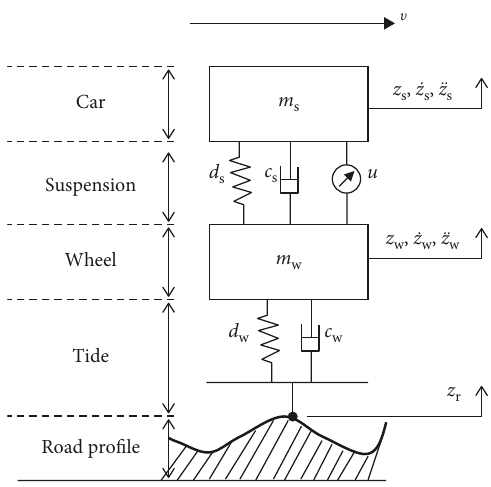
Figure 1: Physical model of a typical suspension system.